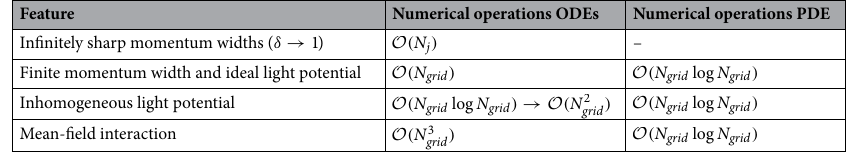
Table 1. Comparison of the different time complexity classes of the commonly-used ODE treatment with the position-space approach developed in this work (PDE-based). Including more and more realistic features of the atom-light system leads to an ODE time complexity unfavourably scaling. The PDE formulation, however, routinely scales with O ( N grid log N grid )